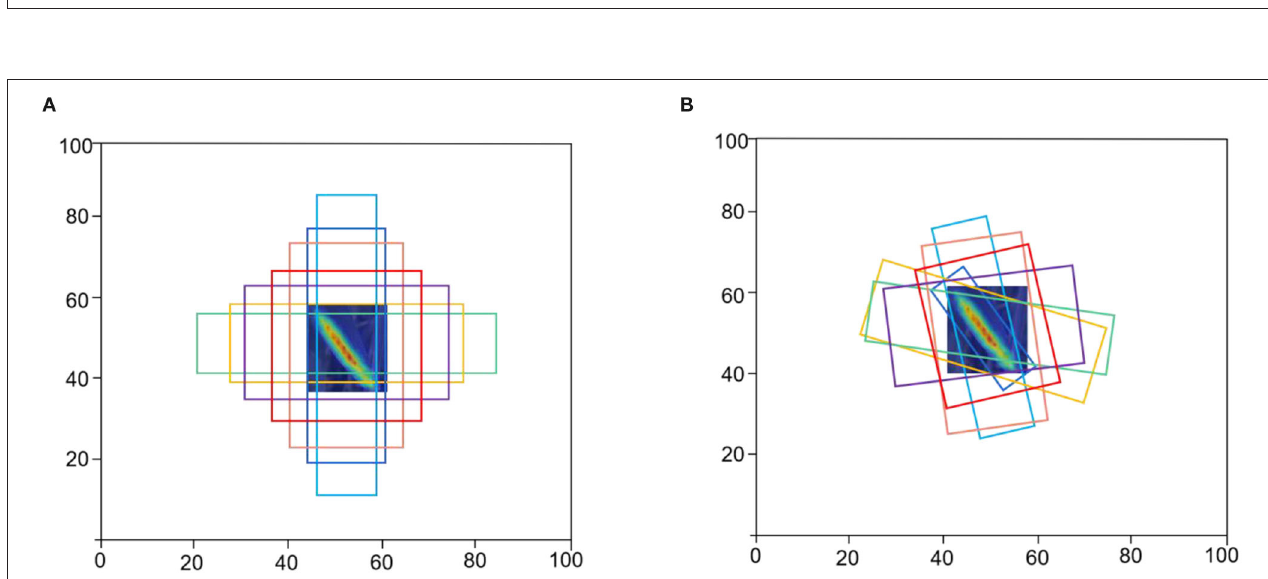
FIGURE 7 | Example of horizontal anchors and refined oriented anchors. (A) Horizontal anchors of the coarse stage and (B) oriented anchors are used in the refined stage.